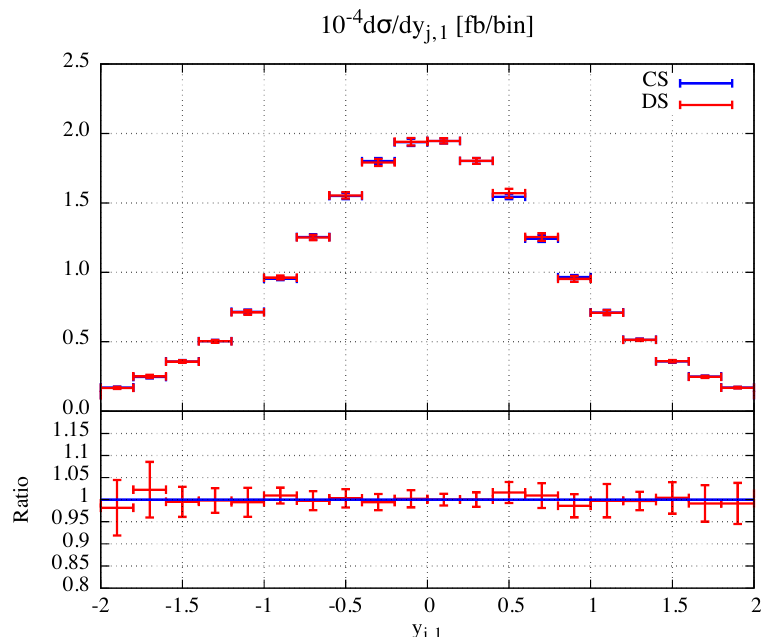
Figure 6. Rapidity distribution of the most energetic jet in γ ∗ → 3 jets (Durham algorithm, √ √ y cut = 0 . 05 , s = 125 GeV, α S ( s ) = 0 . 11173799 ). Only the NLO corrections are plotted. The Dual Subtraction (DS) results are shown in red, while the Catani-Seymour (CS) ones in blue. The error bars correspond to the statistical error given by the Monte Carlo integration.